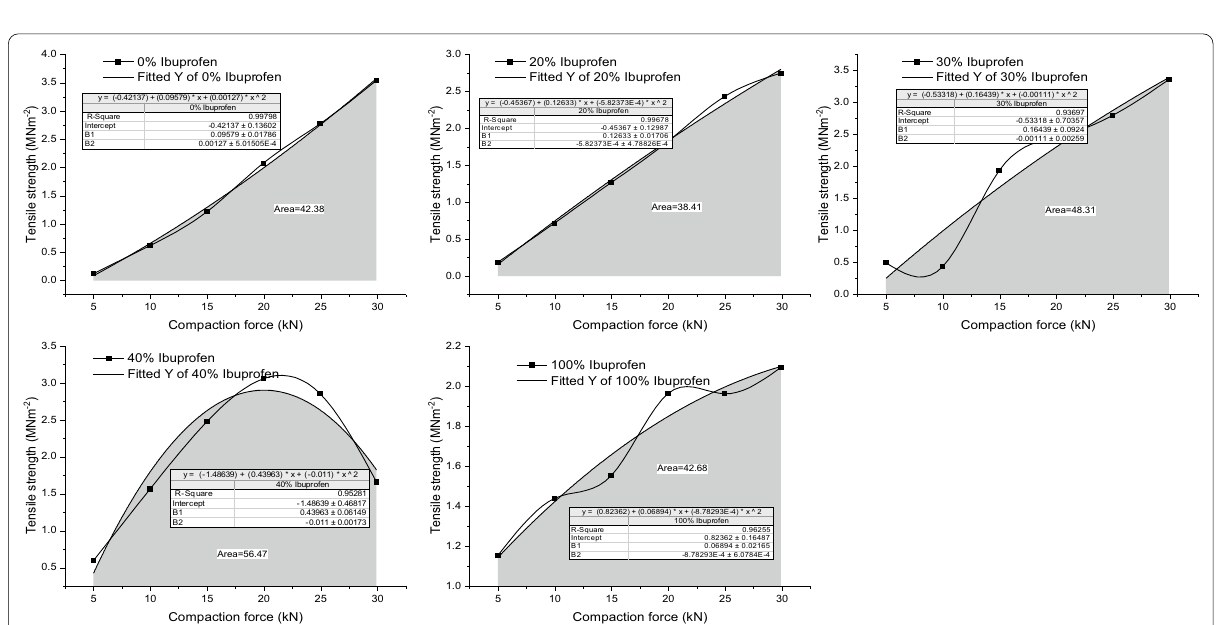
Fig. 3 Area under the tensile strength–compaction force curve for α-lactose-starch orodispersible diluent. Tensile strength computed according to the Shang et al. (2013)